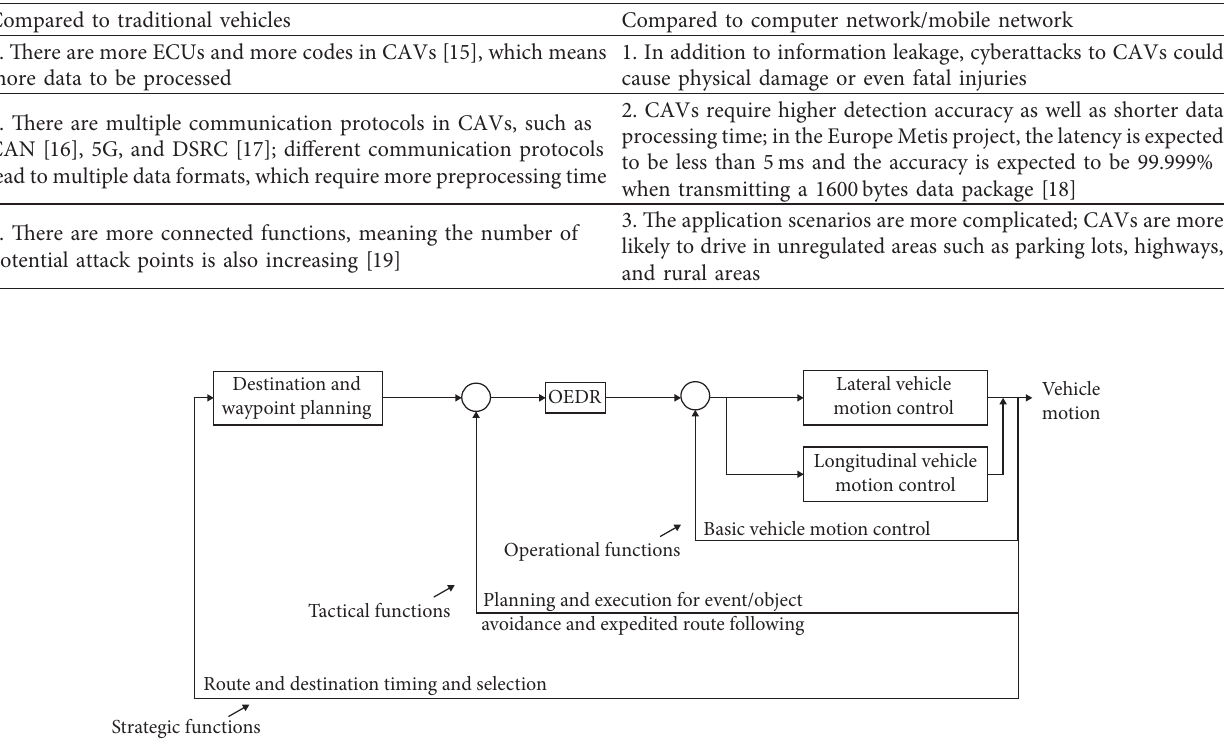
Figure 1: Schematic view of driving tasks